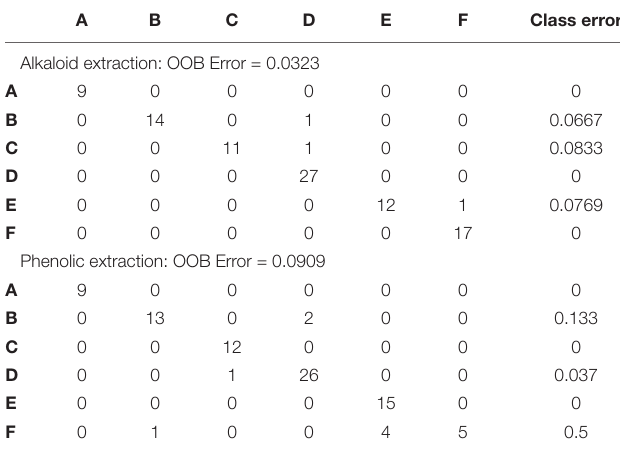
TABLE 5 | Random Forests classification performance